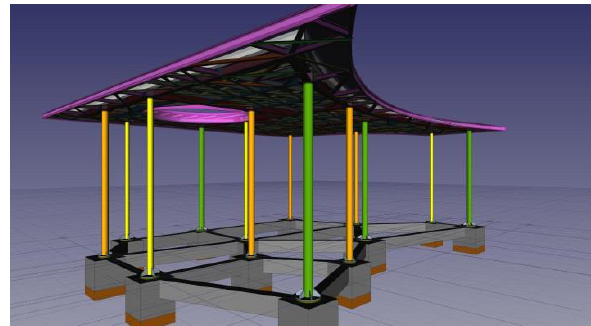
Figure 4. The Freecad BIM Model, a perspective view